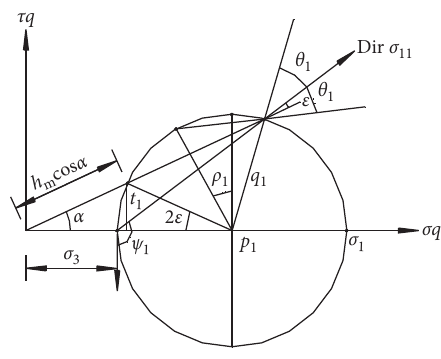
Figure 6: Mohr’s circle for boundary 1.